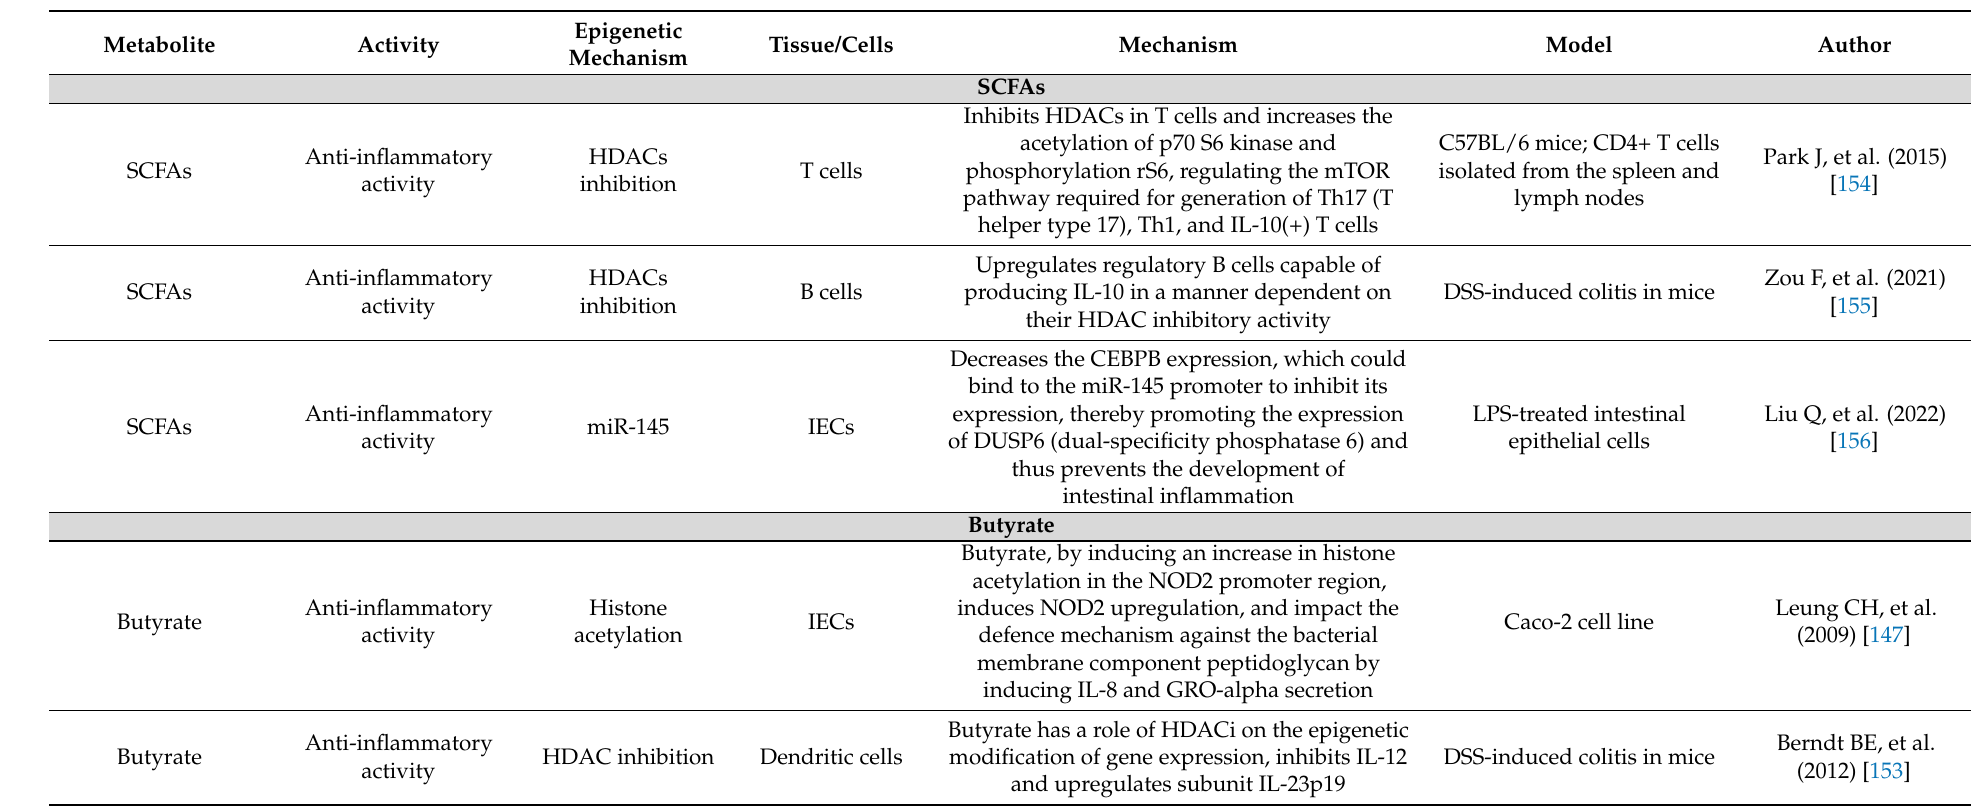
Table 2. Impact of the gut microbiota-derived metabolites on the epigenome in intestinal inflammation . CD, Crohn’s disease; CEBPB, CCAAT/enhancer binding protein; DNA, deoxyribonucleic acid; DSS, dextran sulfate sodium; HDAC, histone deacetylases; IBD, inflammatory bowel disease; IECs, intestinal epithelial cells; IFN, interferon; IL, interleukin; lncRNAs, long non-coding RNAs; LPS, lipopolysaccharide; MCP-1, Monocyte chemoattractant protein-1; miR, micro-RNA; NF- κ B, nuclear factor-kappa B; NOD2, nucleotide-binding oligomerization domain 2; SCFAs, short-chain fatty acids; STAT, signal transducer and activator of transcription; TNF, tumor necrosis factor; UC, ulcerative